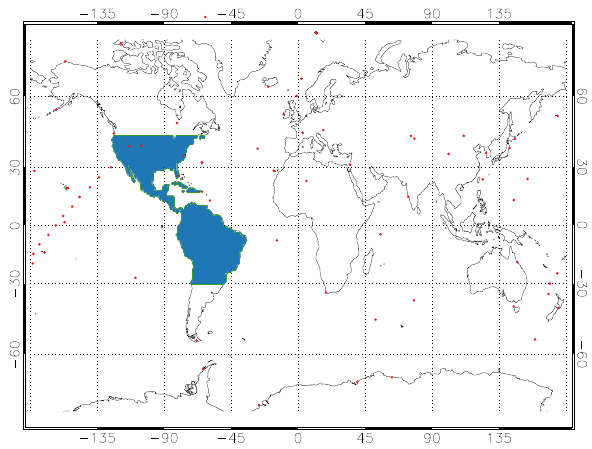
Fig. 1. Map of measurement sites involved in the inversion exper- iments. The blue shaded region is used to compare the inverted wetland CH 4 flux by the different